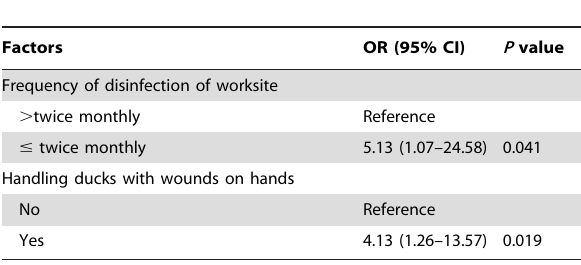
Table 4. Multivariate analysis for risk factors associated with seropositivity for antibodies to H9 virus amongst duck-related workers, Beijing, China.